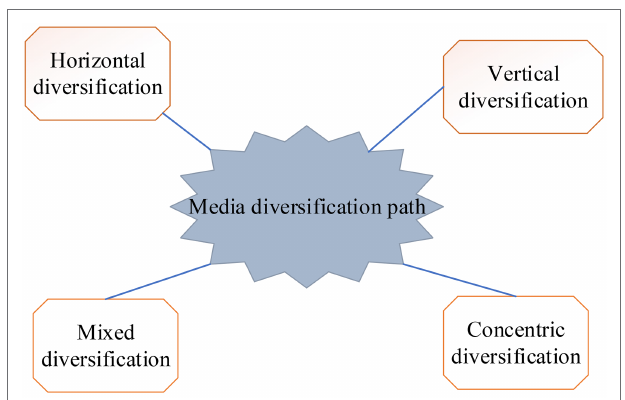
FIGURE 4 | The business path of media diversified